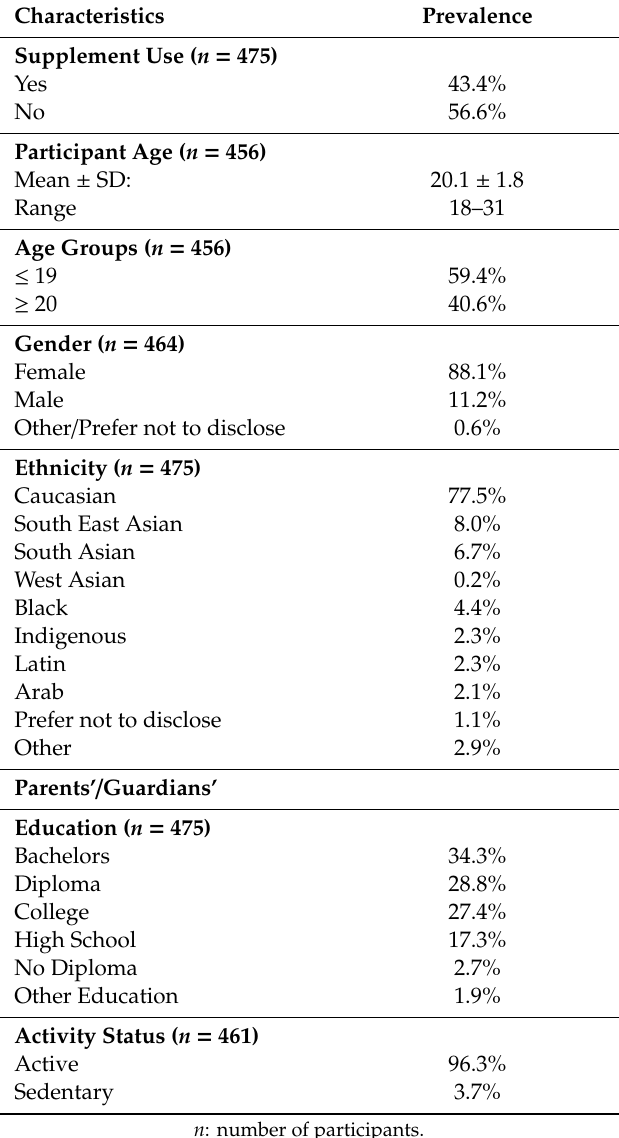
Table 1. Descriptive characteristics of participants.